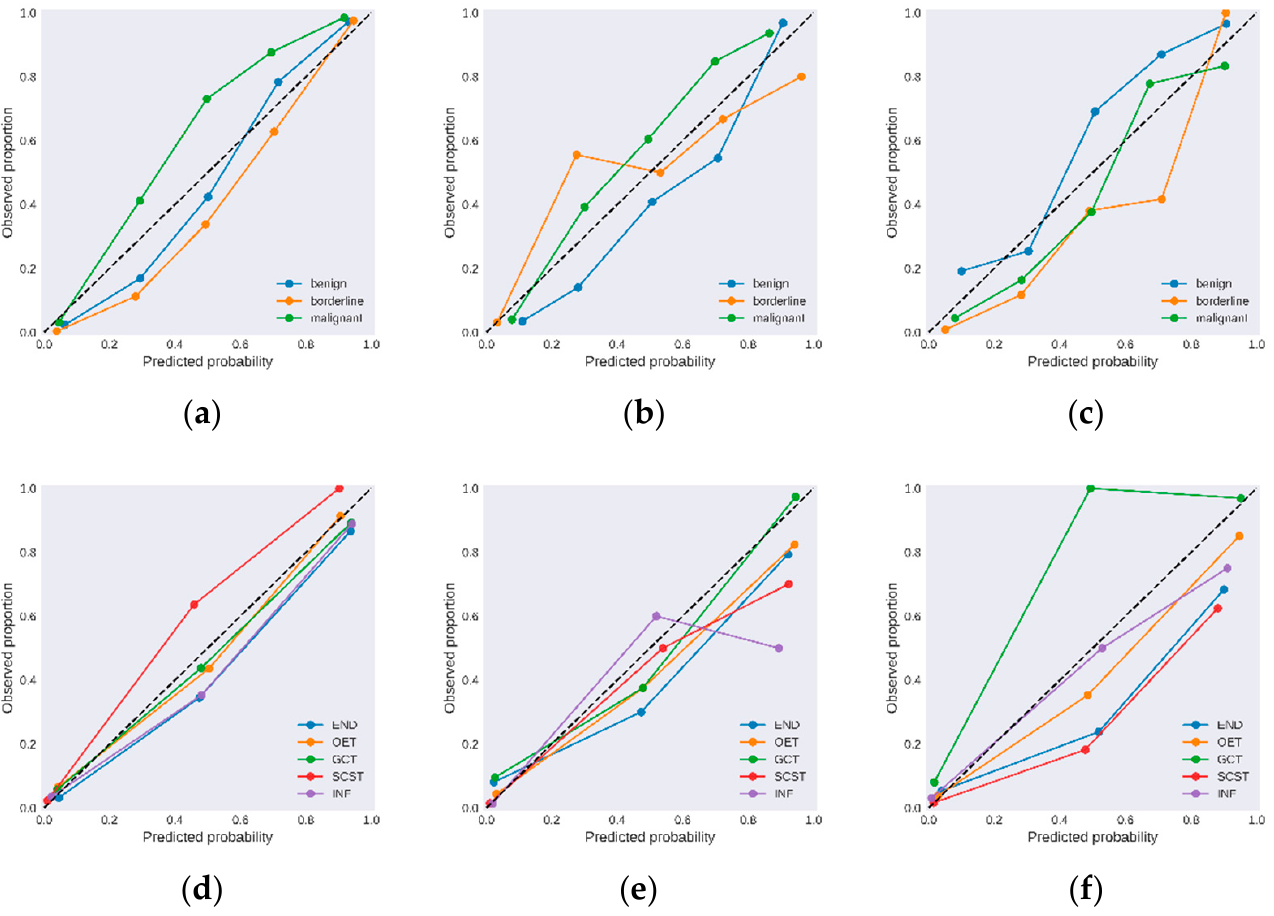
Figure 5. Calibration plots of the type classifier for ( a ) the internal validation dataset, ( b ) external test dataset 1, and ( c ) external test dataset 2. Calibration plots of the pathological subtype classifier for ( d ) the internal validation dataset, ( e ) external test dataset 1, and ( f ) external test dataset 2.